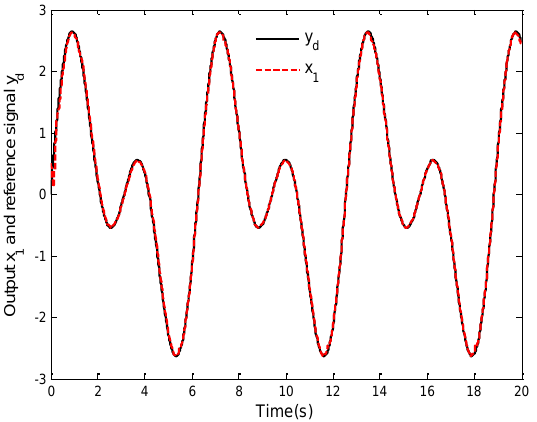
Figure 8. Curves of the tracking performance.